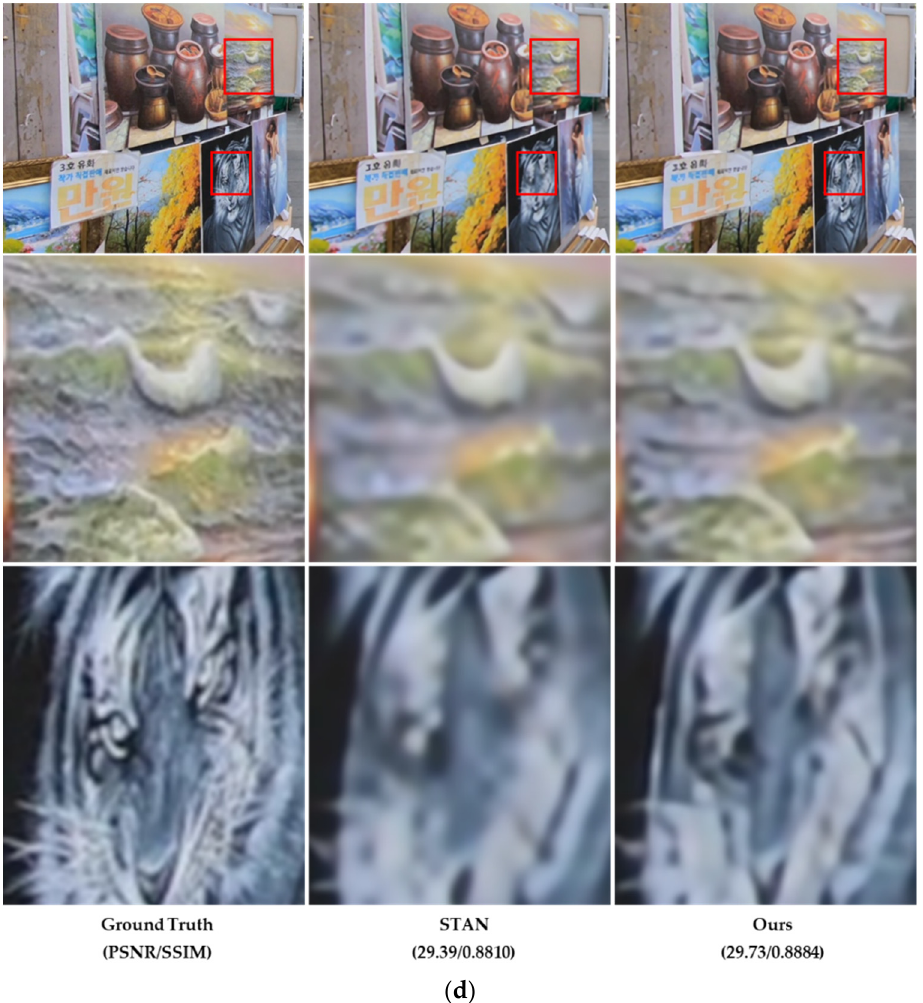
Figure 14. Visual comparisons on REDS4 test dataset (( a – d ): clips 000, 011, 015, and 020 of the REDS training set). For a sophisticated comparison of test datasets, the figures of the second and third rows show the zoom-in for the area in the red